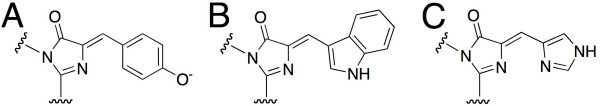
Chromophore structures of mTFP1 and its hue-shifted variants. (A) The chromophore structure shared by EGFP, mTFP1 and mWasabi. (B) The chromophore structure shared by ECFP and the mTFP1-Y67W variant. (C) The chromophore structure shared by EBFP and the mTFP1-Y67H variant.